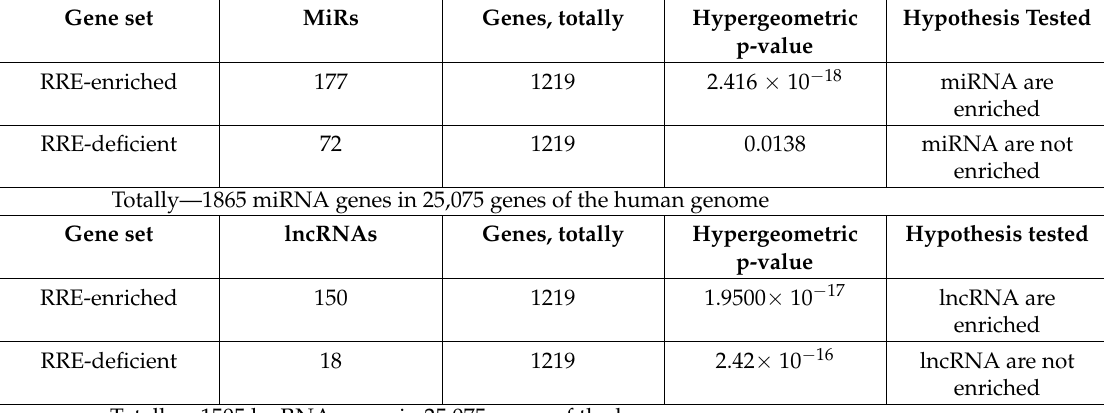
Table 5. RRE-enriched and deficient microRNA and lncRNA genes ( all